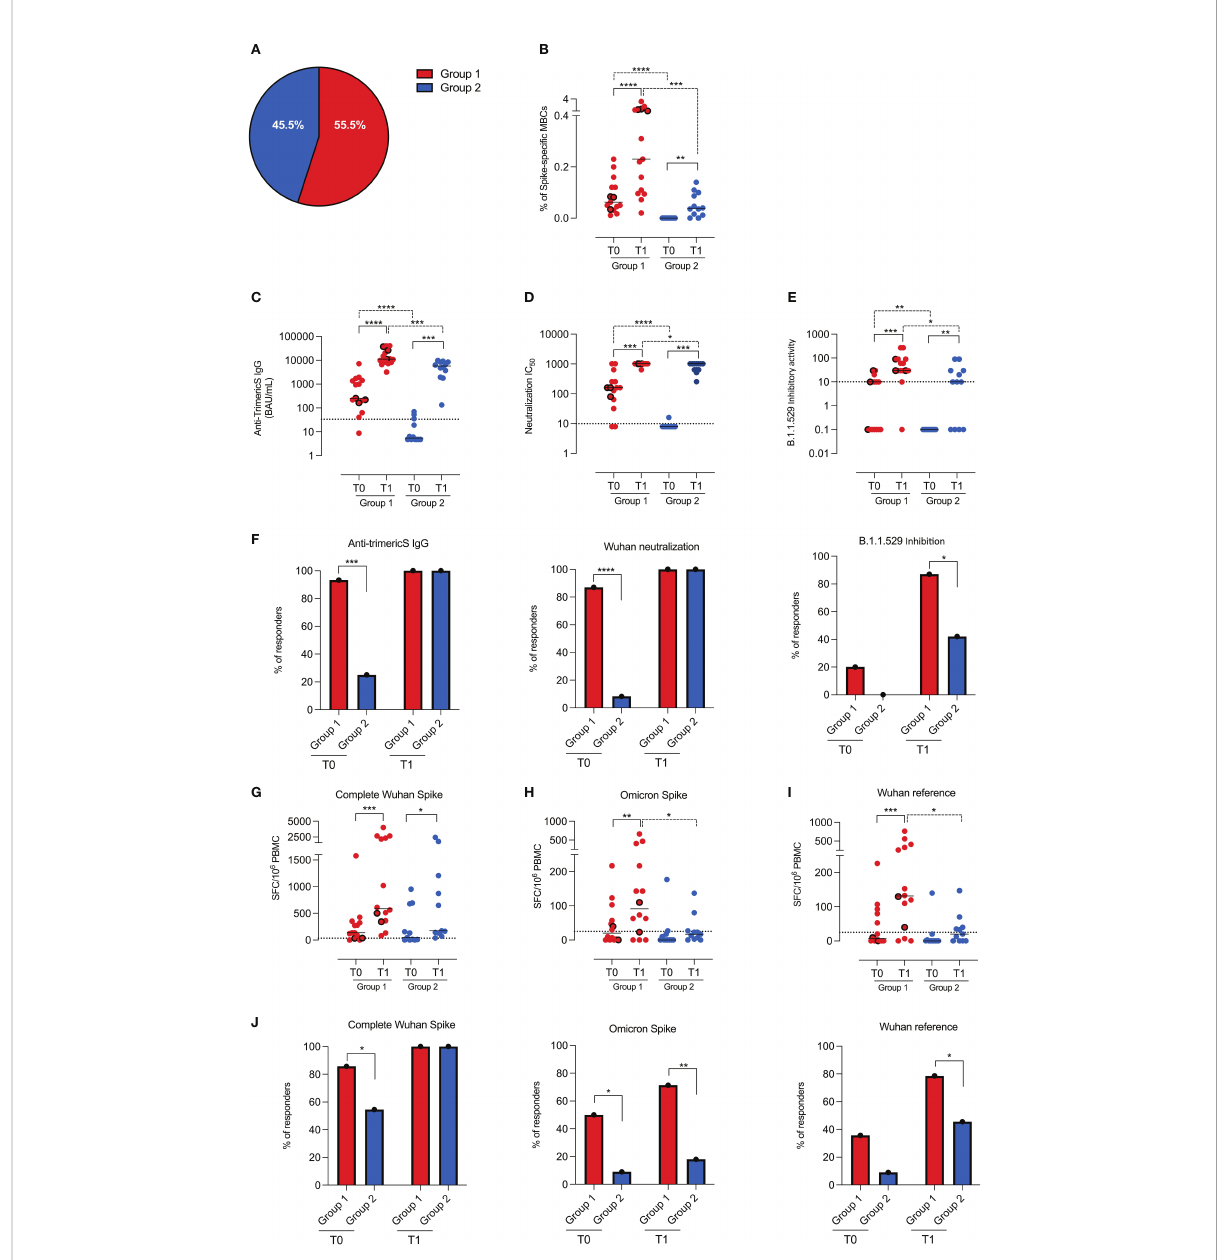
FIGURE 3 Humoral and cellular immunity in groups 1 and 2. (A) Pie chart represents the percentage of children with (group 1, n=15) and without (group 2, n=12) spike-speci fi c memory B cells before vaccination (T0). (B) Dot chart depicts the frequency of spike-speci fi c memory B cells in the two groups before (T0) and 10 days after vaccination (T1). Concentration of anti-TrimericS IgG (BAU/mL) and neutralization titers, reported as IC50 against the Wuhan viral strain are shown in (C, D) , respectively. (E) Graph indicates the inhibitory activity against the Omicron VOC in the two groups. (F) Bar charts represent the percentage of children in group 1 and group 2 with anti-TrimericS IgG (BAU/mL), neutralizing antibodies against the complete Wuhan spike and antibodies able to inhibit the binding of ACE-2 to the Omicron RBD. Dot charts show the number of T cells, expressed as numbers of spot-forming cells (SFC)/10 6 PBMC, producing IFN gamma after stimulation with peptides encompassing the complete Wuhan spike protein (complete Wuhan spike) (G) , the spike region mutated in the Omicron VOC (H) and its unmutated counterpart (I) . (J) Bar charts represent the percentage of responders in group 1 and group 2 against the complete Wuhan spike protein, the spike region mutated in the Omicron VOC and its unmutated counterpart. Dashed lines indicate the cutoff value for each test. Bars indicate medians and dots with thick borders show values measured in children that had experienced COVID-19 before vaccination (n=3). Non-parametric Wilcoxon matched pair signed-rank test (continuous line) and Mann – Whitney t-test (dashed line) were used to evaluate statistical signi fi cance. Categorical variables were compared by Chi-Square exact test. Two-tailed P value signi fi cances are shown as * p<0.05, **p < 0.01, ***p < 0.001, ****p <